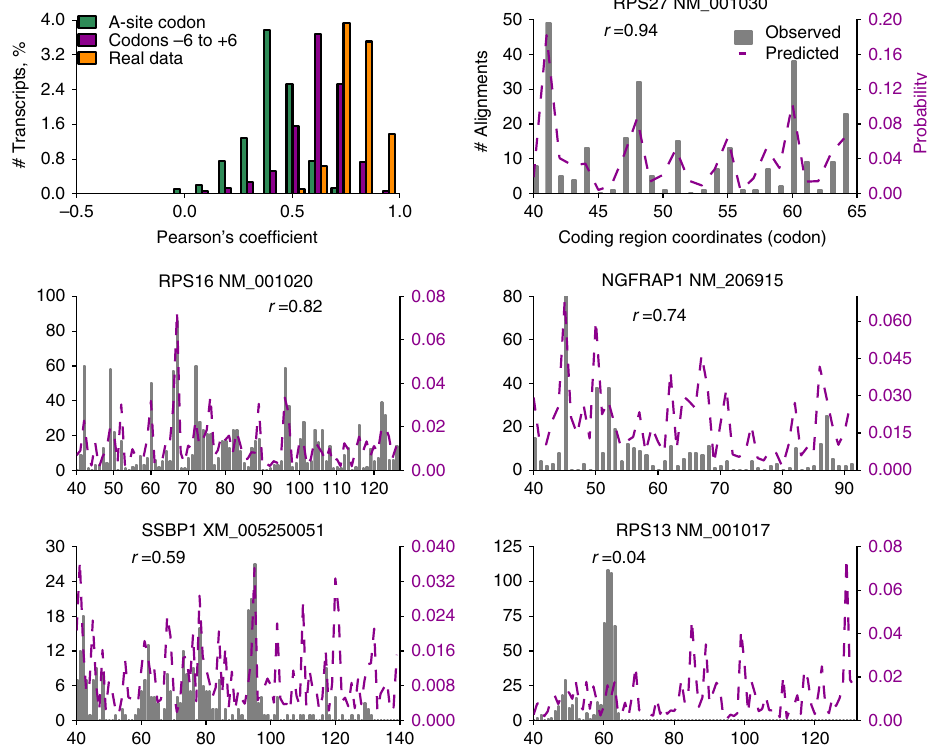
Figure 4 | RUST accurately predict experimental footprint densities. Top left panel shows distributions of Pearson’s correlation coefficients for experimental and predicted footprint densities (green and violet) for individual transcripts as well as correlation between two experimental ribo-seq data sets obtained under the same protocol (orange). Correlations were measured only for coding regions of highly expressed transcripts from 120 nucleotides downstream of the start codons to 60 nucleotides upstream of the stop codons. The other panels show experimental (solid grey) and predicted (based on RUST values for the codons –6 to þ 6 relative to A-site) ribosome densities (broken purple) for five transcripts, corresponding to the first, 10th, 100th, 500th and 714th strongest correlations, the Pearson’s correlation coefficients are indicated. Results displayed are for ’Andreev’ data